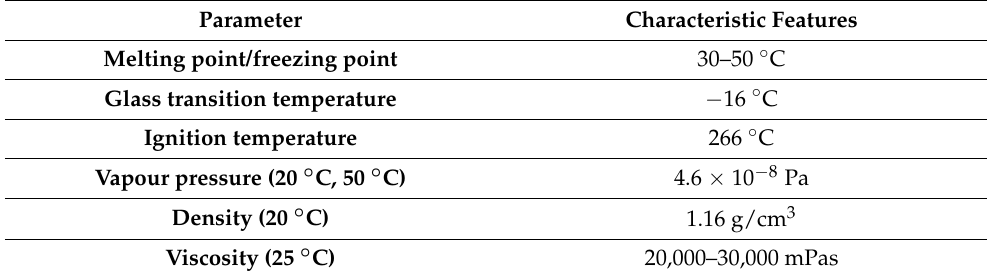
Table 1. Typical parameters of epoxy resin based on Epidian 5